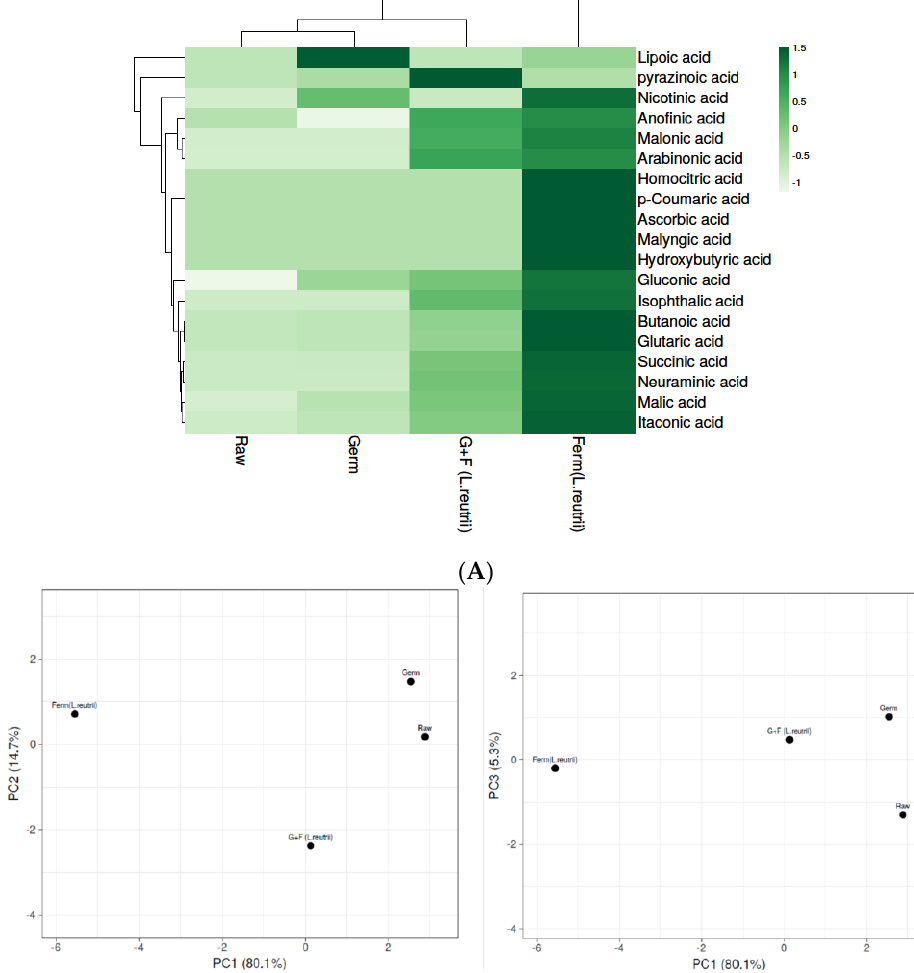
Figure 4. Levels of organic acids in Raw, Germinated, Fermented ( L. reuterii AKT1) and G+F ( L. reuterii AKT1) samples. ( A ) The heat map shows different levels of organic acids in samples based on colours as green to white represents the level of organic acids in decreasing order. ( B ) Identification of principal component analysis (PCA) of Raw, Germ, Ferm ( L. reuterii AKT1) and G+F samples was shown by comparing PC1 with PC2 and PC1 with PC3. Germ- germinated brown rice, Ferm- fermented brown rice, G+F- germinated + fermented brown